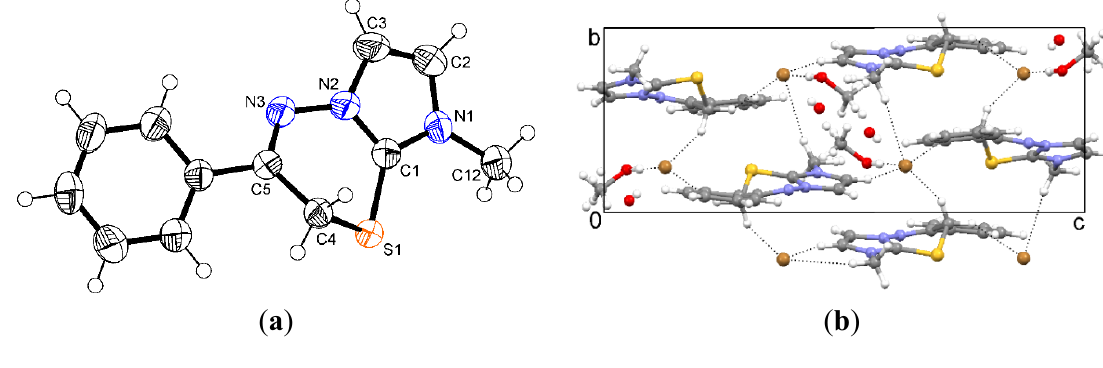
Table 2. Hydrogen bond parameters and short contacts (Å,